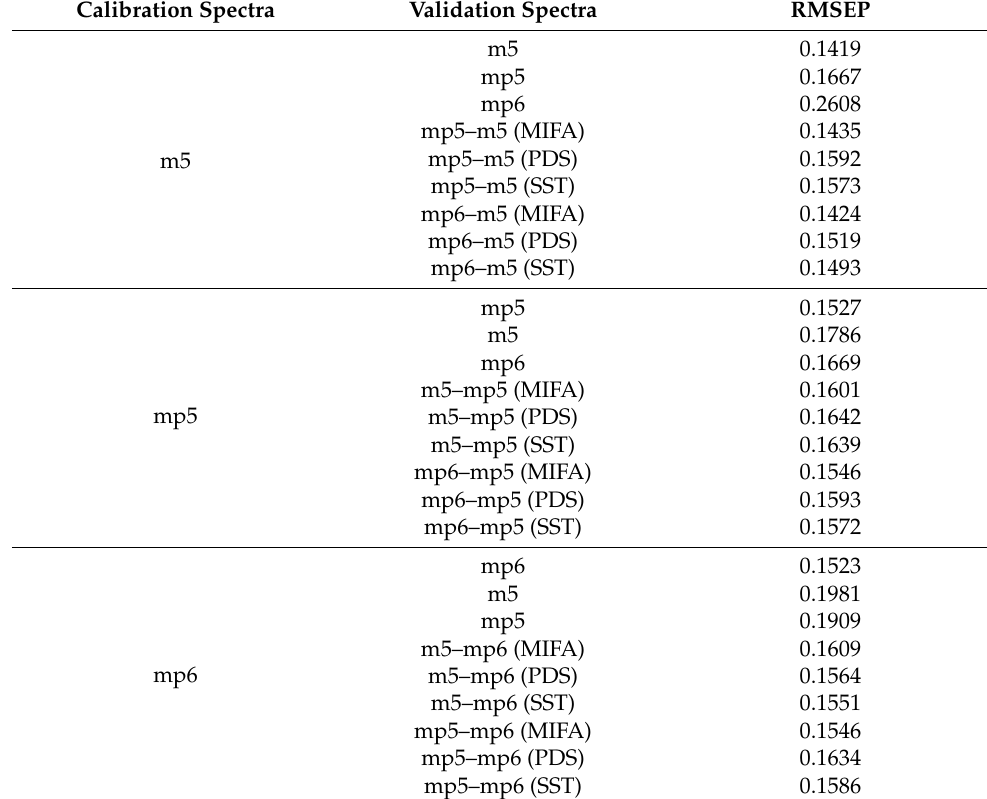
Table 1. Comparison of the results obtained by PDS, SST and MIFA for dataset 1.